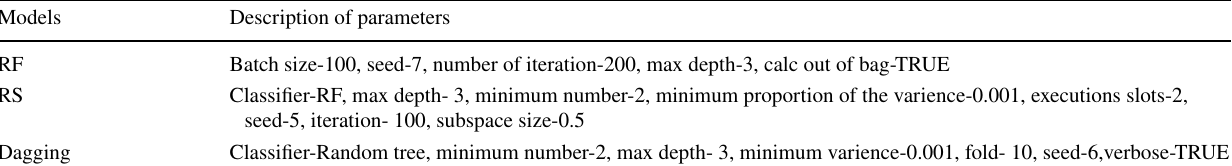
Table 3 The optimization parameters of the EML algorithms employed for GWP mapping Models Description of